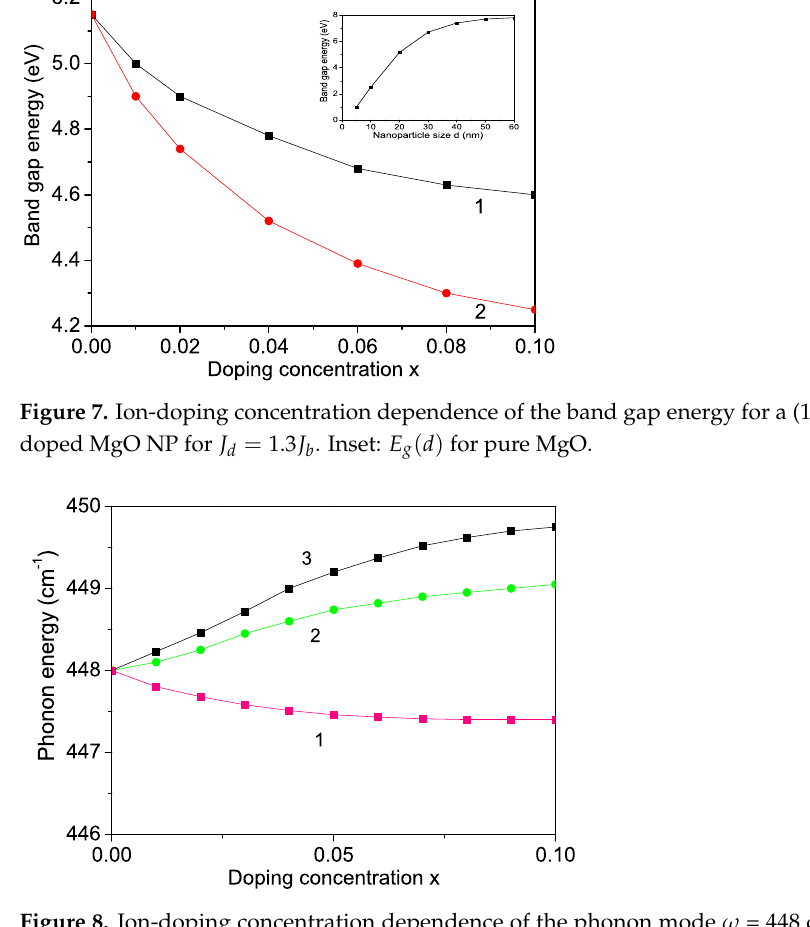
Figure 8. Ion-doping concentration dependence of the phonon mode ω = 448 cm − 1 of a MgO NP, d = 20 nm, for T = 20 K and different ions: (1) Sr with R d = 0.8 R b ; (2) Fe, R d = 1.2 R b ; (3) Co, R d = 1.4 R b .